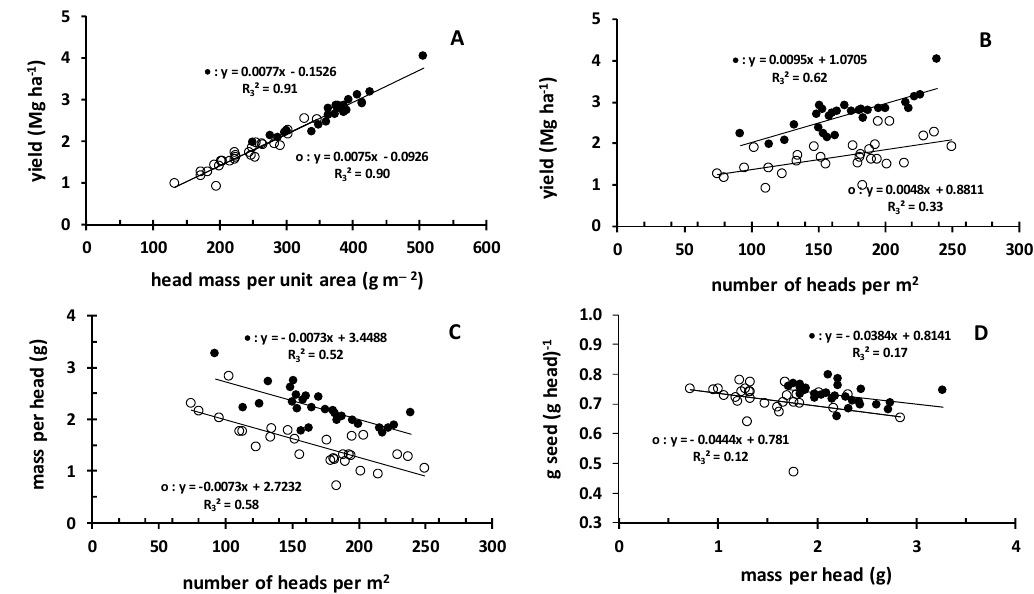
Figure 4. The relationships of the data provided by the treatments of the randomized plot experiments of the 2016–2017 growing season (Group B). Full circles: Data of Group B1 (P-Olsen: 18–22 ppm). Empty circles: Data of Group B2 (P-Olsen: 12–15 ppm). In each set of data, the tendency is described by including a trend line of linear type.